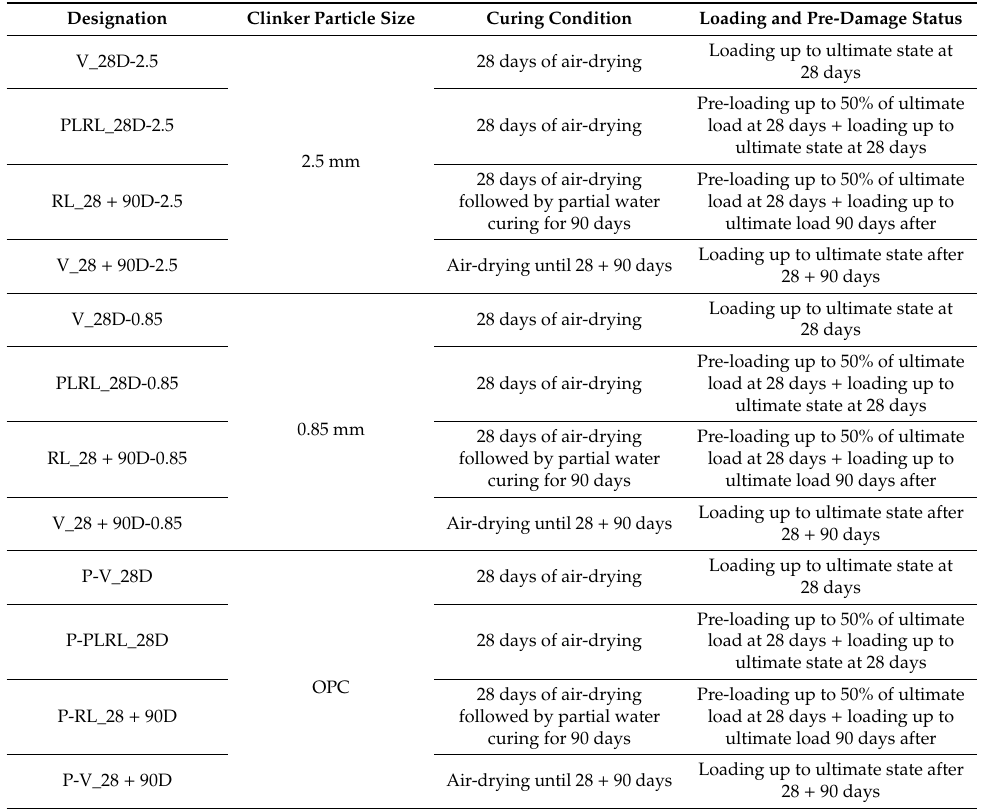
Table 4. Designation and specifications of test